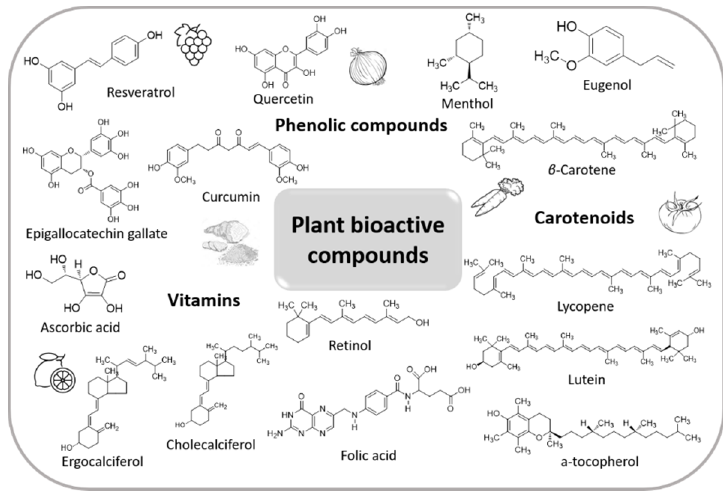
Figure 1. Representative classes of plant-derived bioactive compounds.